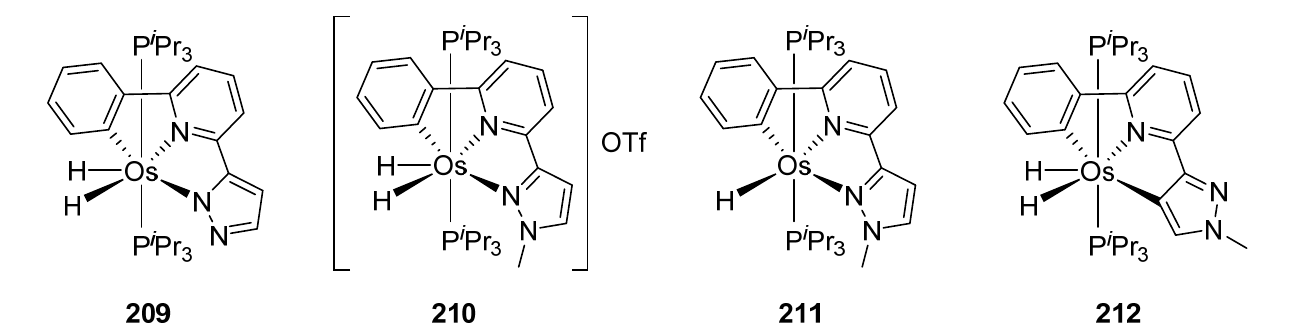
Figure 53. Phosphorescent C~N~N and C~N~C osmium pincer complexes.